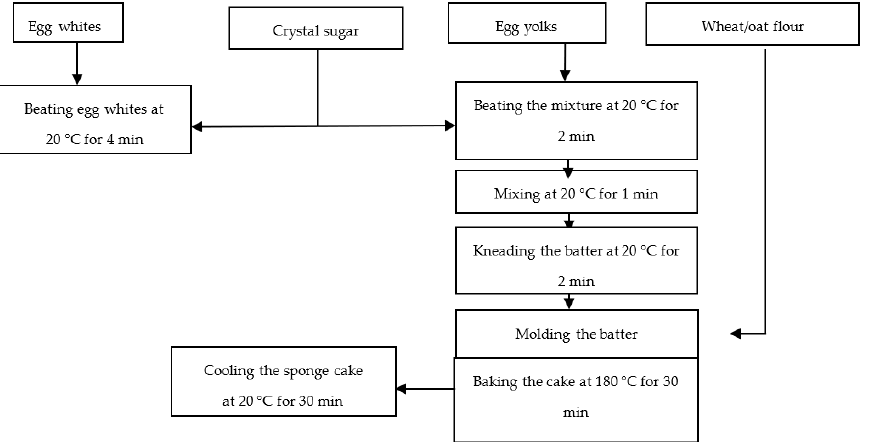
Figure 7. Technological scheme for the preparation of sponge cake control.